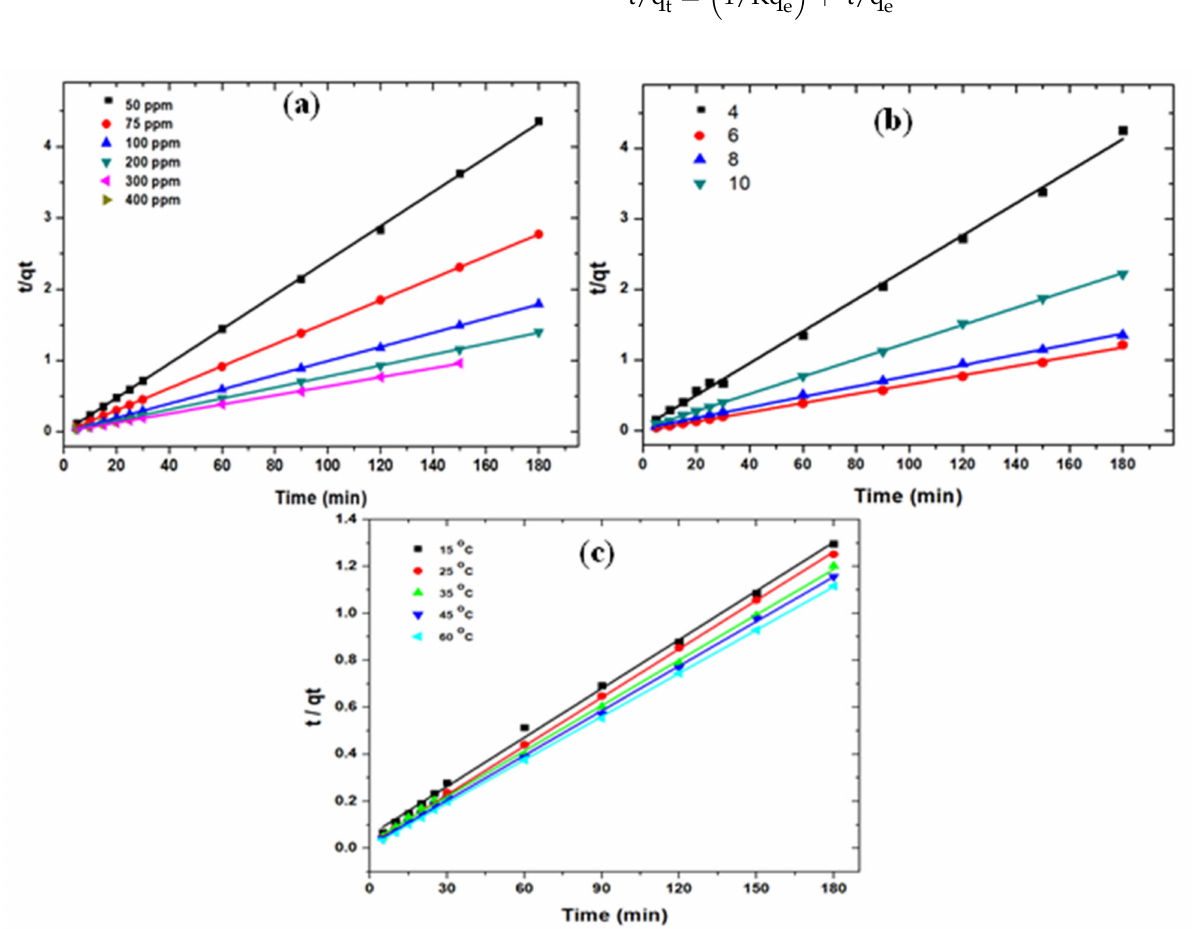
Figure 6. Pseudo 2nd order kinetic plots showing influence of varied ( a ) adsorbate concentration, ( b ) pH and ( c ) temperature on diclofenac adsorption over g-C 3 N 4 /MoO 3 (3%) nanohybrid. K 1 (min − 1 ) and K 2 (g mg − 1 min − 1 ) represent rate constants of pseudo 1st and pseudo 2nd order kinetic equations; q e (mg g − 1 ) equilibrium adsorption capacity and q t (mg g − 1 ) refers to temporal adsorption